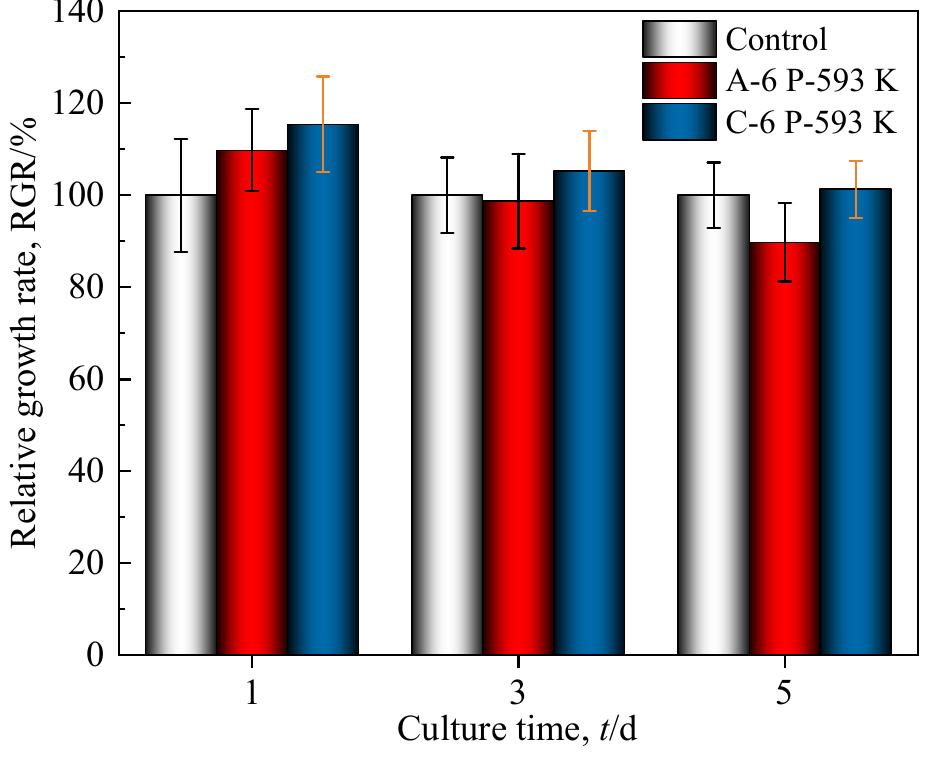
Figure 10. The relative growth rate (RGR) of L929 cells cultured with extracts of A-6 P-593 K and C-6 P-593 K specimens.